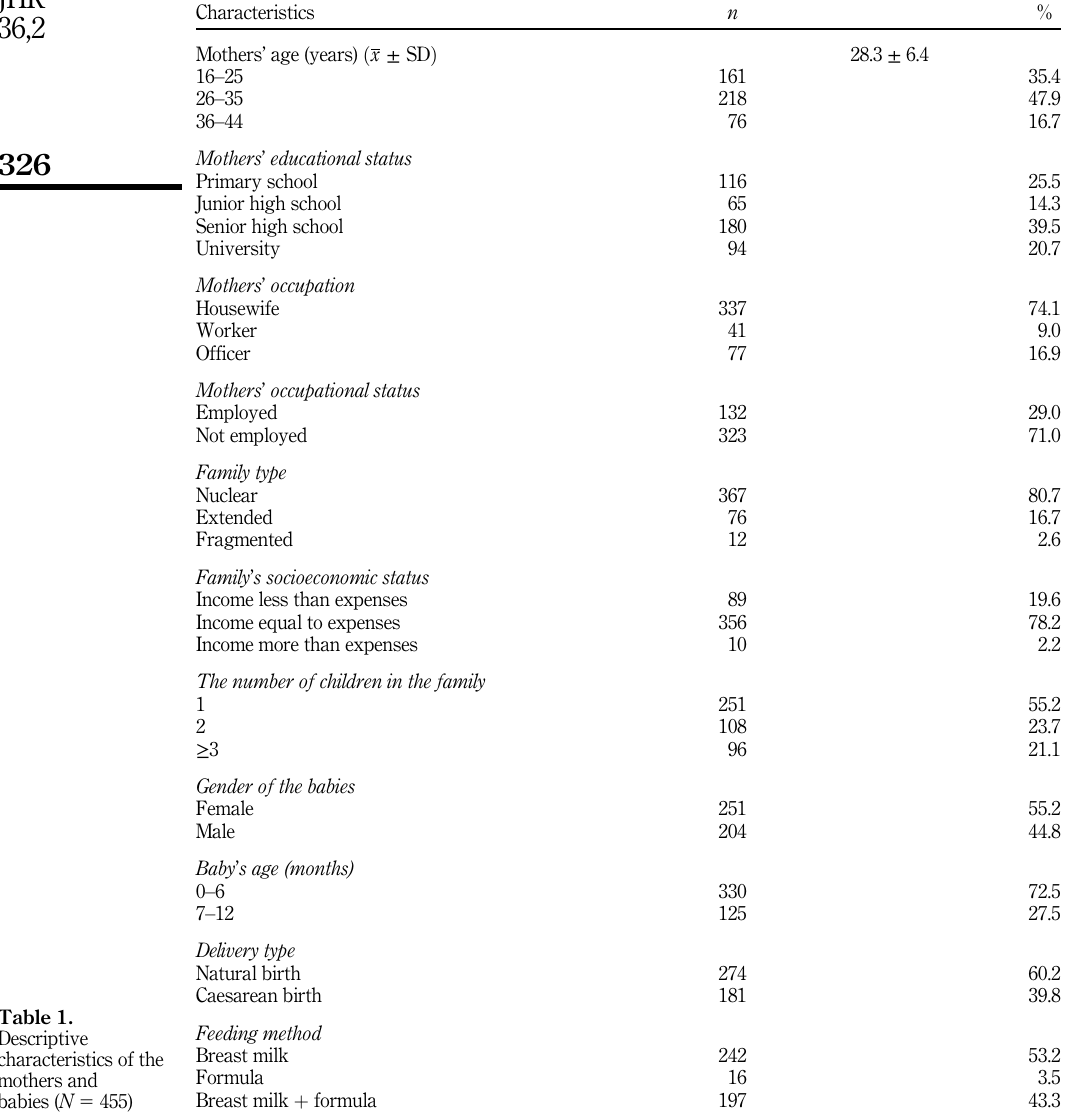
characteristics of the mothers and babies ( N 5